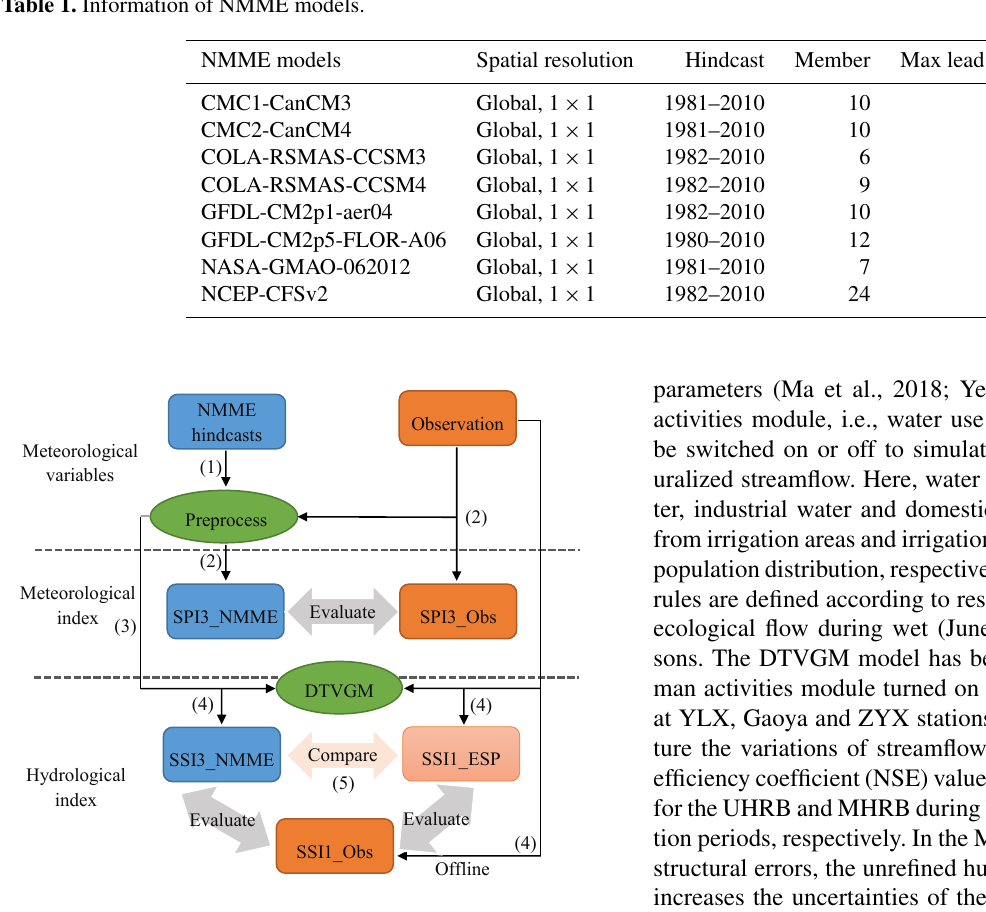
Figure 2. Flow chart explaining the seasonal meteorological and hydrological drought forecasting system. The numbers (1)–(5) re- fer to the steps for the development and assessment of a seasonal drought prediction